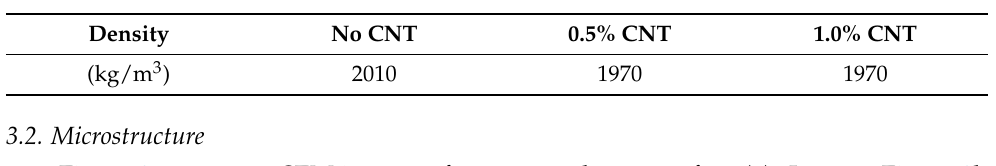
Table 4. Density of